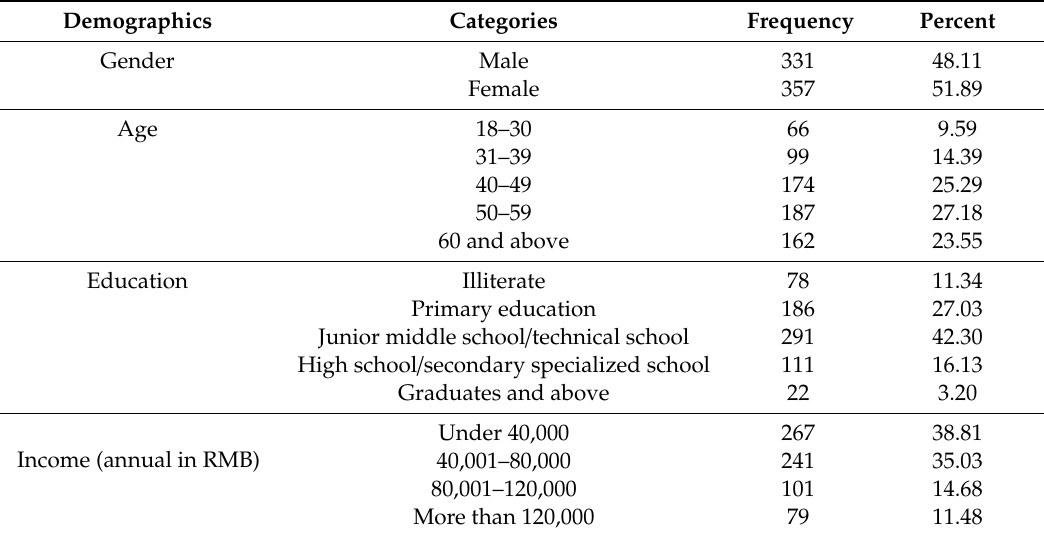
Table 1. Demographic characteristics of samples (N =